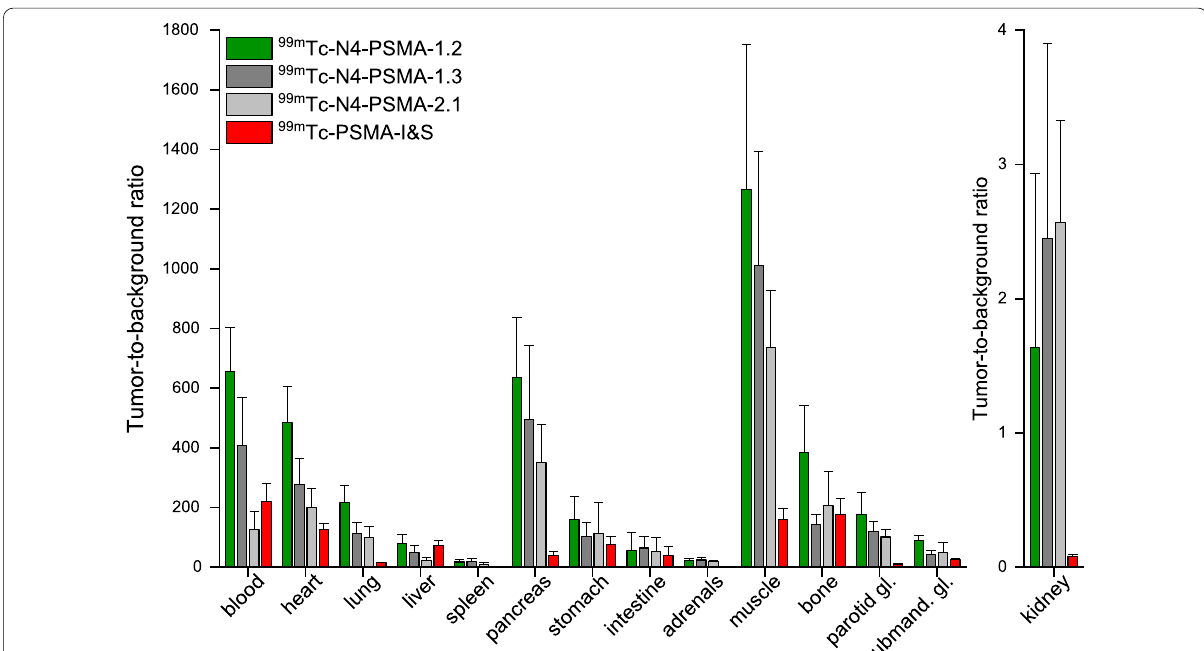
Fig. 5 Tumor‑to‑background ratios (TBR) of 99m Tc‑labeled N4‑PSMA compounds and [ 99m Tc]Tc‑PSMA‑I&S at 6 h p.i. in male LNCaP tumor‑bearing CB17‑SCID mice. Data are given as mean standard deviation ( n 4–5). Mean values were determined from TBR calculated for individual animals. ± = gl.: gland; submand.: